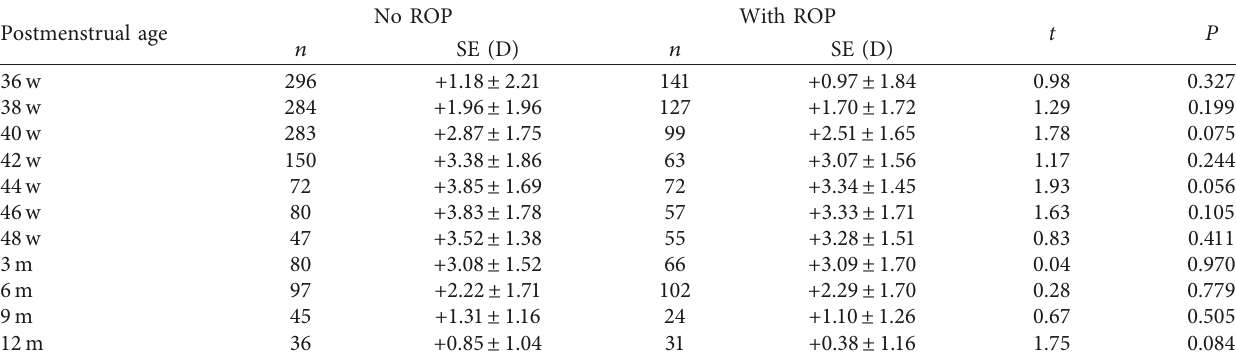
Table 5: SE of the presence or absence of ROP.